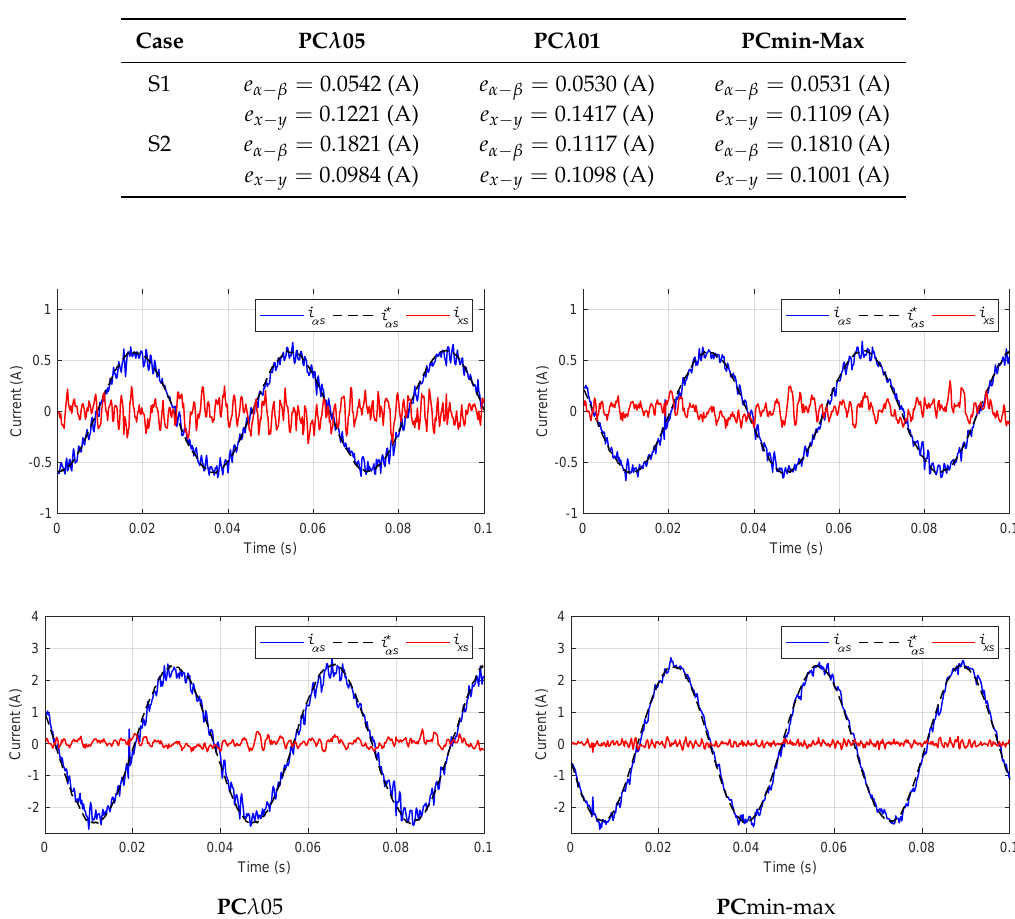
Table 2. Simulation results for the traditional and proposed predictive controllers in terms of tracking errors.